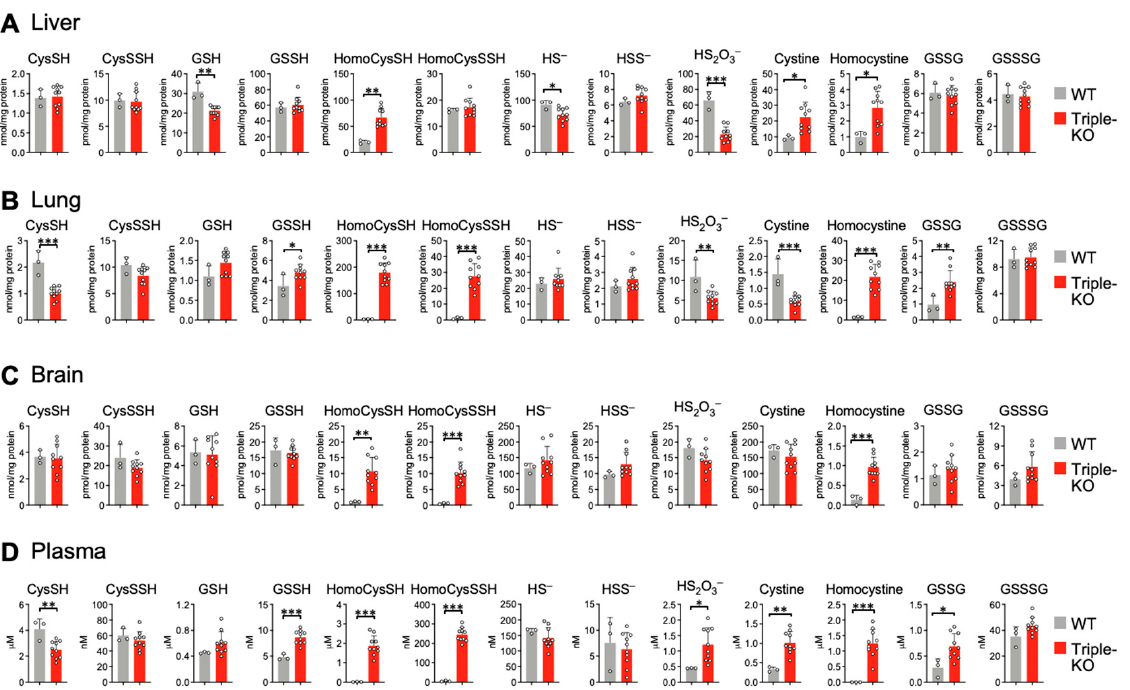
Figure 3. Sulfur metabolome analysis in triple-KO mice. Endogenous production of CysSSH, GSSH, and related compounds was identified by means of HPE-IAM labeling with LC–MS/MS analysis of the liver ( A ), lung ( B ), brain ( C ), and plasma ( D ) obtained from control and triple-KO mice. Mice were males, 14–16 weeks old. Data are means ± s.d. n = 3 (WT) and 10 (triple-KO). * p < 0.05; ** p < 0.01; *** p < 0.001, as determined by Student’s t